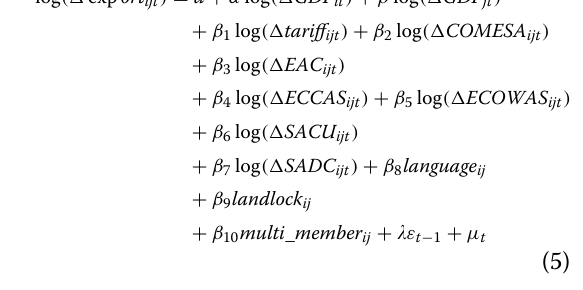
Table 5 The long run result. Dependent variable: Export ijt Variable Coefficient Std. Error